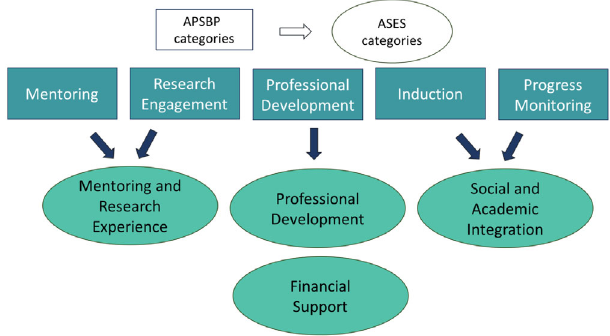
FIG. 1. The APSBP components that loaded into each ASES component.